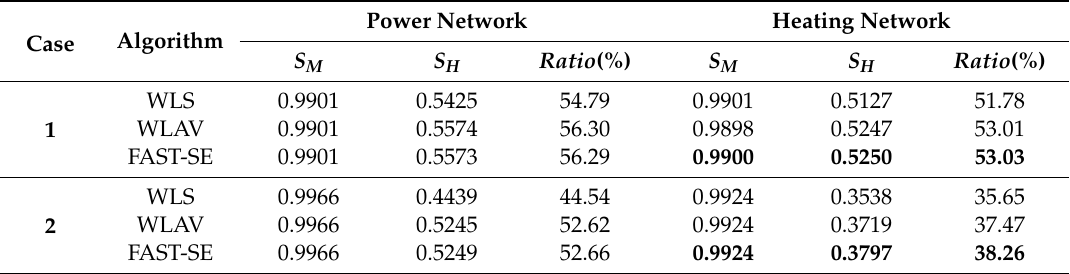
Table 1. The comparison of statistical results. WLS: weighted least square; WLAV: weighted least absolute value;